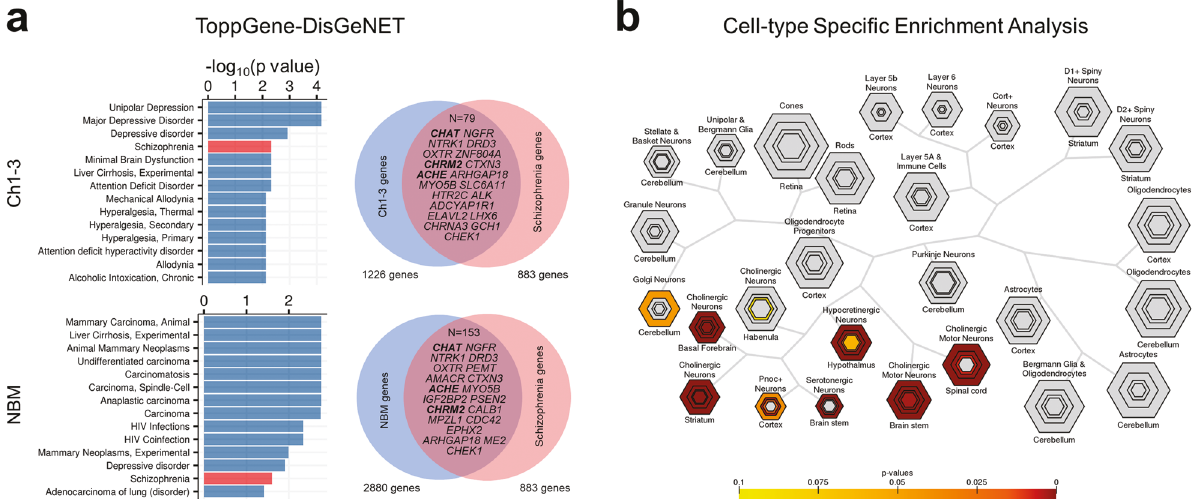
Fig. 4 Transcriptomic analysis of the basal forebrain structures. a Enrichment of schizophrenia related genes. Venn diagram shows overlap between genes highly expressed in Ch1-3 and NBM with schizophrenia-related genes based on DisGeNET. Bolded genes are associated with cholinergic function ( CHAT, ACHE, CHRM2 ). b CSEA of genes passing FDR ( q < 0.10) shows enrichment for cholinergic neurons in the Ch1-3. Coloured cell types indicate signi fi cance after multiple testing correction (FDR q < 0.10). Hexagon sizes indicate cell-type speci fi city at varying speci fi city index probability (pSI) statistic thresholds from 0.05 to 1e − 4, such that the outer hexagons indicate the least speci fi c test for a cell type (pSI threshold 0.05) while the innermost hexagon indicates the most speci fi c test for a cell type (pSI 1e −